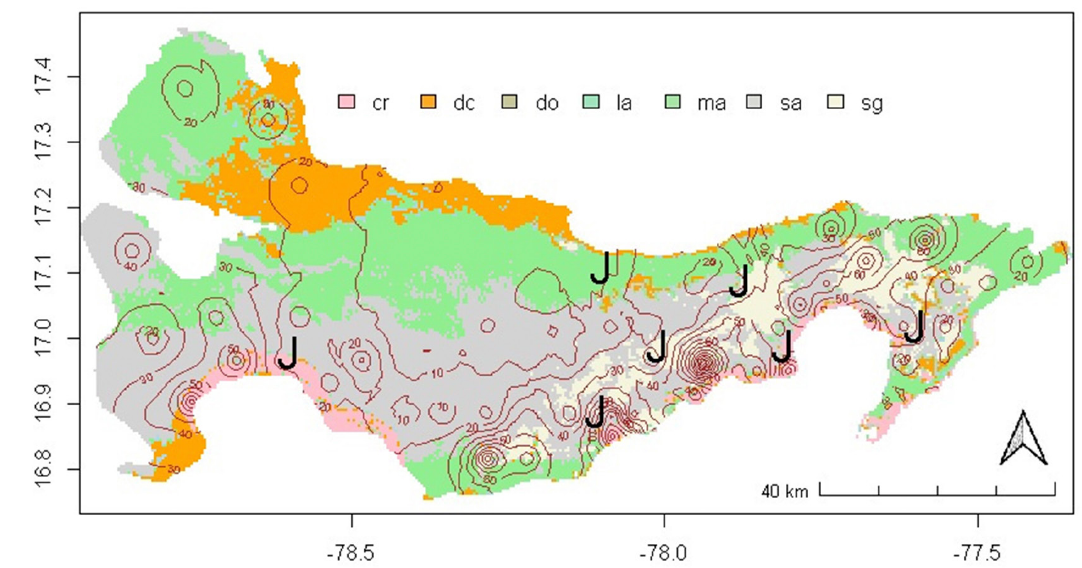
Fig. 6. – Habitat map of the Pedro Bank based on Baldwin (2015) overlaid with predicted adult abundance distribution 2015 (isolines) and the relative location of high-density juvenile patches (“J”). Abundance isolines units are in number of conches per pixel. cr, coral reef; dc, deep coral; do, deep ocean; la, land; ma, macroalgae hardground; sa, sand and sediment; sg,